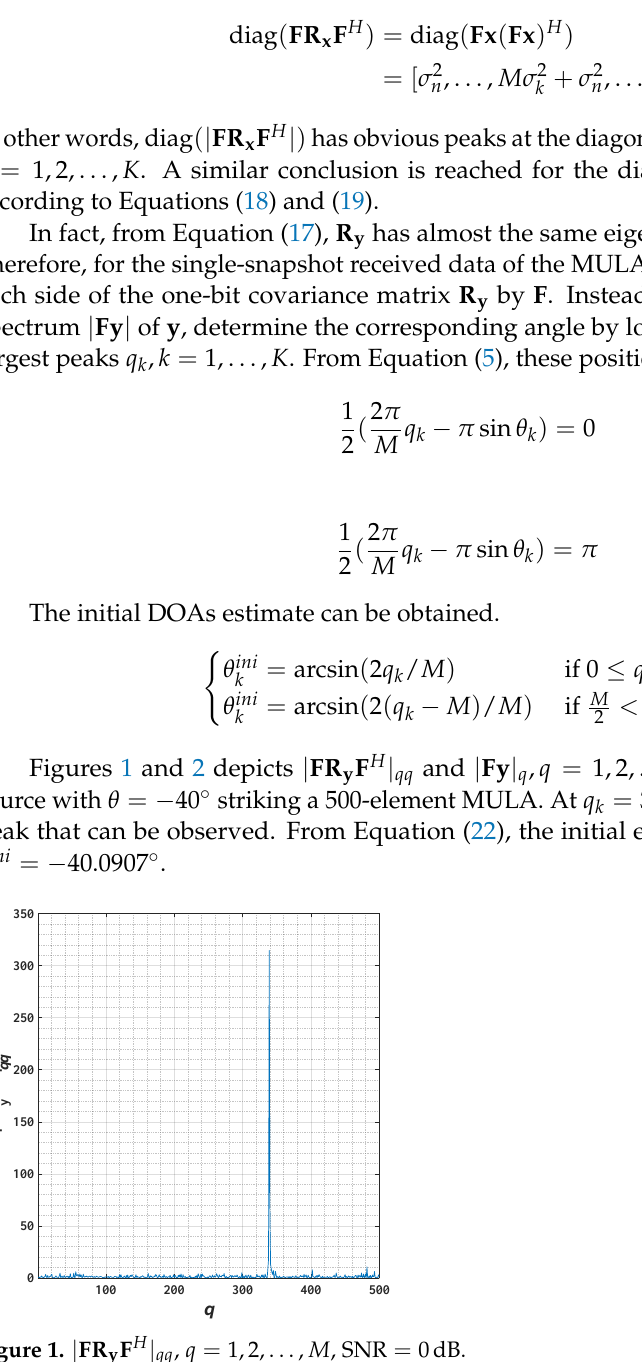
Figure 1. | FR y F H | qq , q = 1,2, . . . , M , SNR =